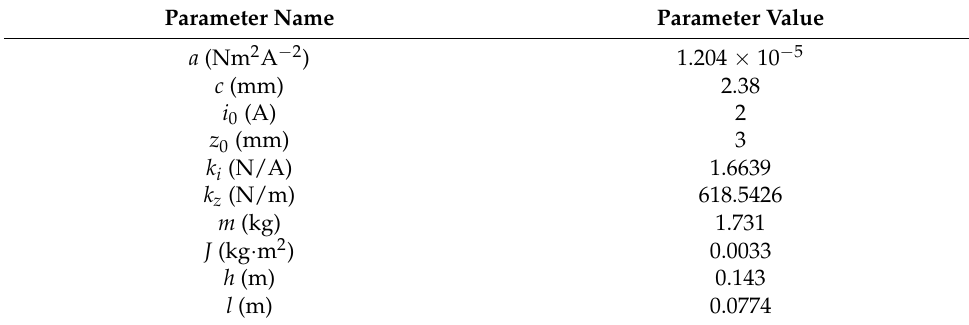
Table 3. Main parameters of the plant